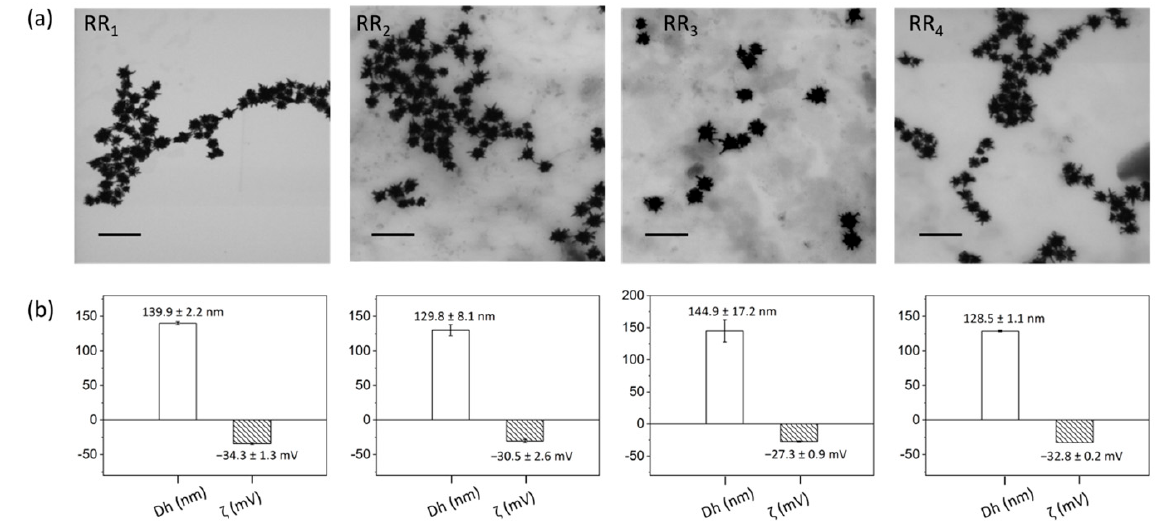
Figure 5. ( a ) TEM images, ( b ) size distribution (Dh), and zeta potential values ( ζ ) of RR@AuNSts acquired after the implementation of the optimized RRs conjugation. Scalebar is 200 nm in all cases.